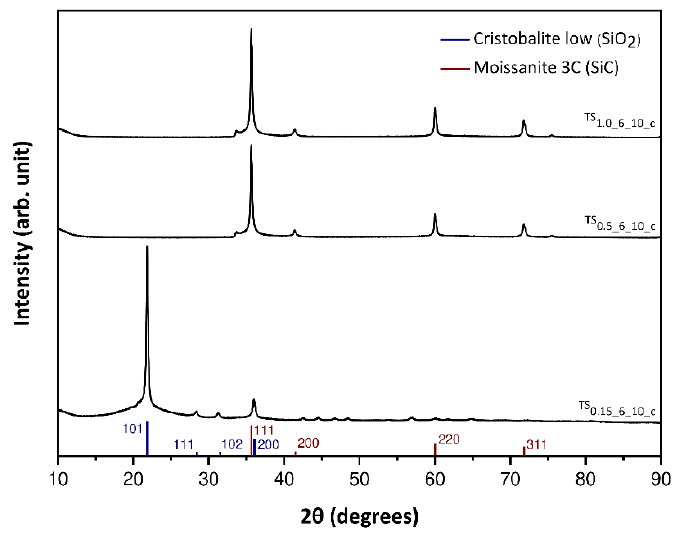
Figure 10. XRD patterns of the samples TS 0 . 15_6_10_c , TS 0 . 5_6_10_c and TS 1 . 0_6_10_c after carbothermal treat- ment under argon atmosphere at 1500 °C for 5 h.